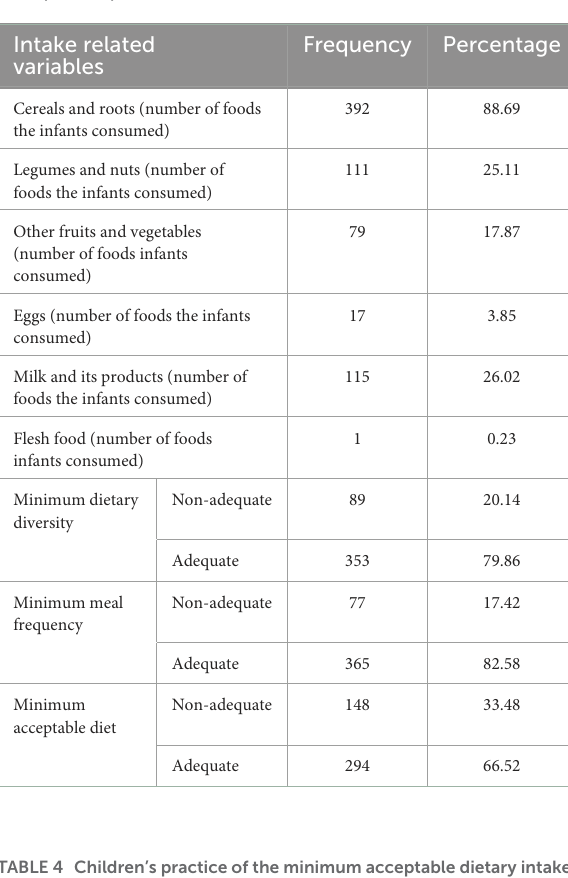
TABLE 3 Level of a minimum acceptable diet intake percentage by 6–23-month-old infants in South Gondar Zone, Northwest Ethiopia, 2017 ( n = 442).